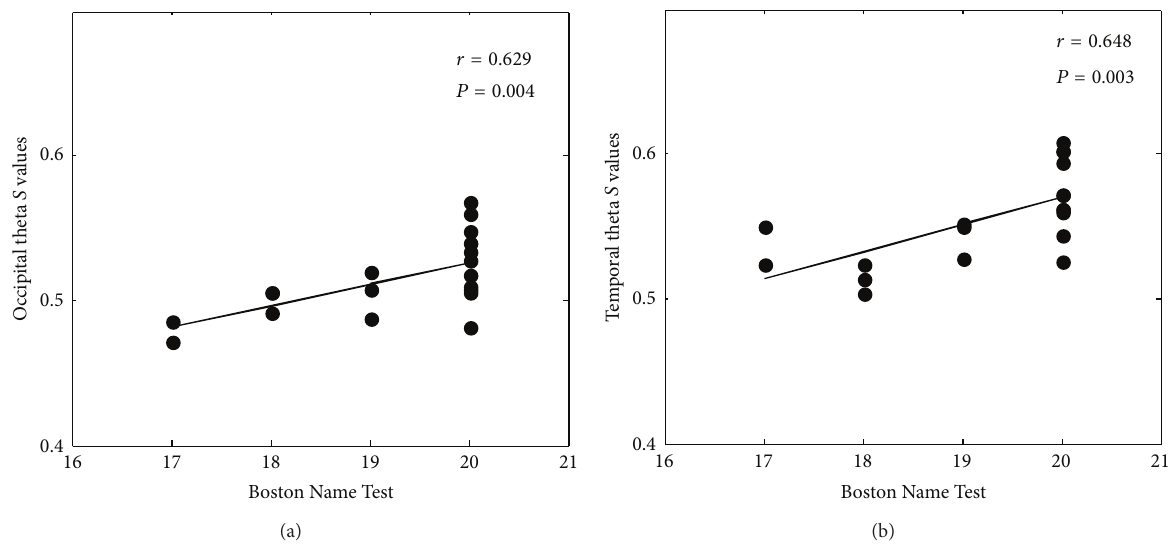
Figure 2: Correlation analysis between cortical source EEG synchronous and the scores of the neuropsychological tests in all subjects as a whole group (only significant correlations were displayed). 𝑆 values as a function of Boston Name Test within temporal theta and occipital theta were reported; the correlation was 𝑟 = 0.629 , 𝑃 = 0.004 and 𝑟 = 0.648 , 𝑃 = 0.003 ,